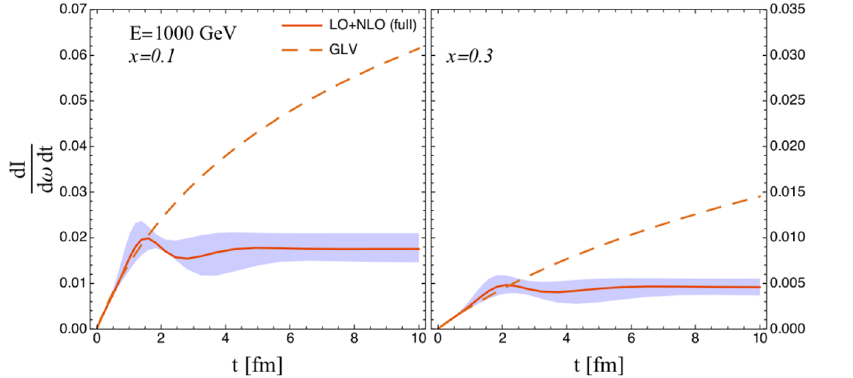
Figure 3 . The rate of medium-induced emissions for a gluon jet with energy E = 1 TeV. Medium parameters are ^ q = 1 : 5 GeV 2 /fm and (cid:22) = 1